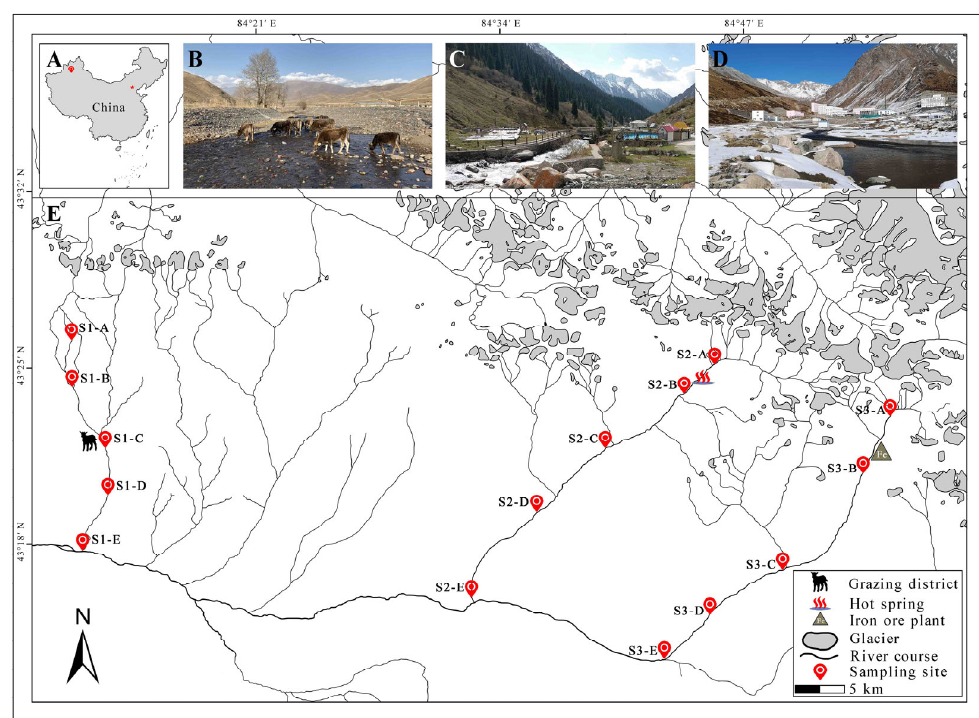
Figure 1. ( A ) Map showing the Ili River Basin located in the People’s Republic of China; ( B ) The grazing stream (S1 C–E); ( C ) The hot spring stream (S2-B); ( D ) The mining stream (S3-B); ( E ) The locations of the sampling sites within the three streams of study. Glacier data sites from the second glacier inventory dataset of China [46].